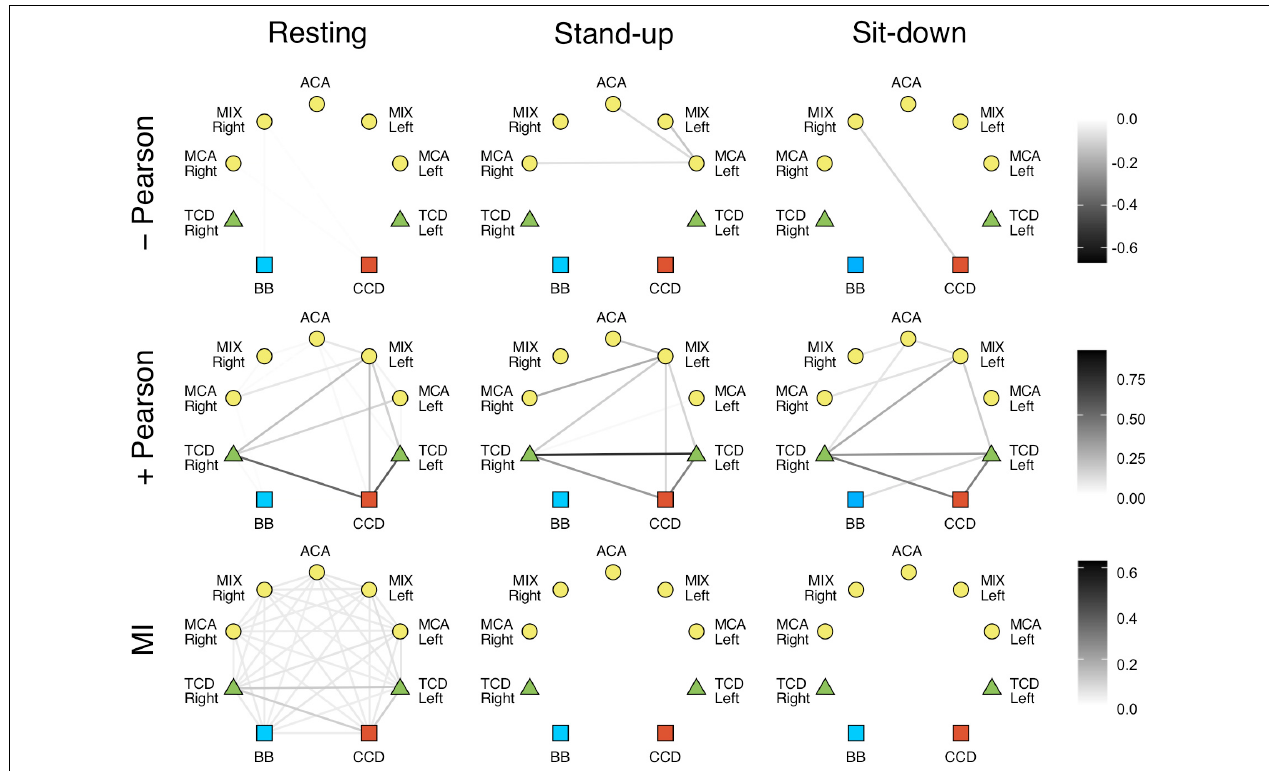
FIGURE 4 | Cardiorespiratory-cerebrovascular networks reconstructed for the low-frequency range (0.02–0.4 Hz) after surrogate thresholding. Connection strength was assessed using Pearson correlation analysis (upper panels: negative correlations, middle panels: positive correlations) and mutual information analysis (MI, lower panels) and is coded in grayscale. CCD, Cardiac cycle duration; BB, Breath-to-breath interval; TCD, transcranial Doppler (denoting the BFV signal recorded from MCA); ACA, anterior cerebral artery; MCA, middle cerebral artery; MIX, NIRS channels sampling regions supplied by ACA and